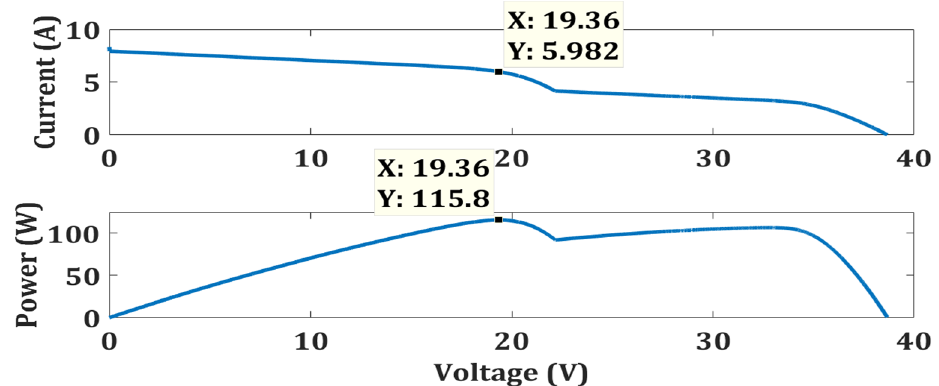
Figure 26. Characteristic curves of 3S2P PV system for test case 2 .